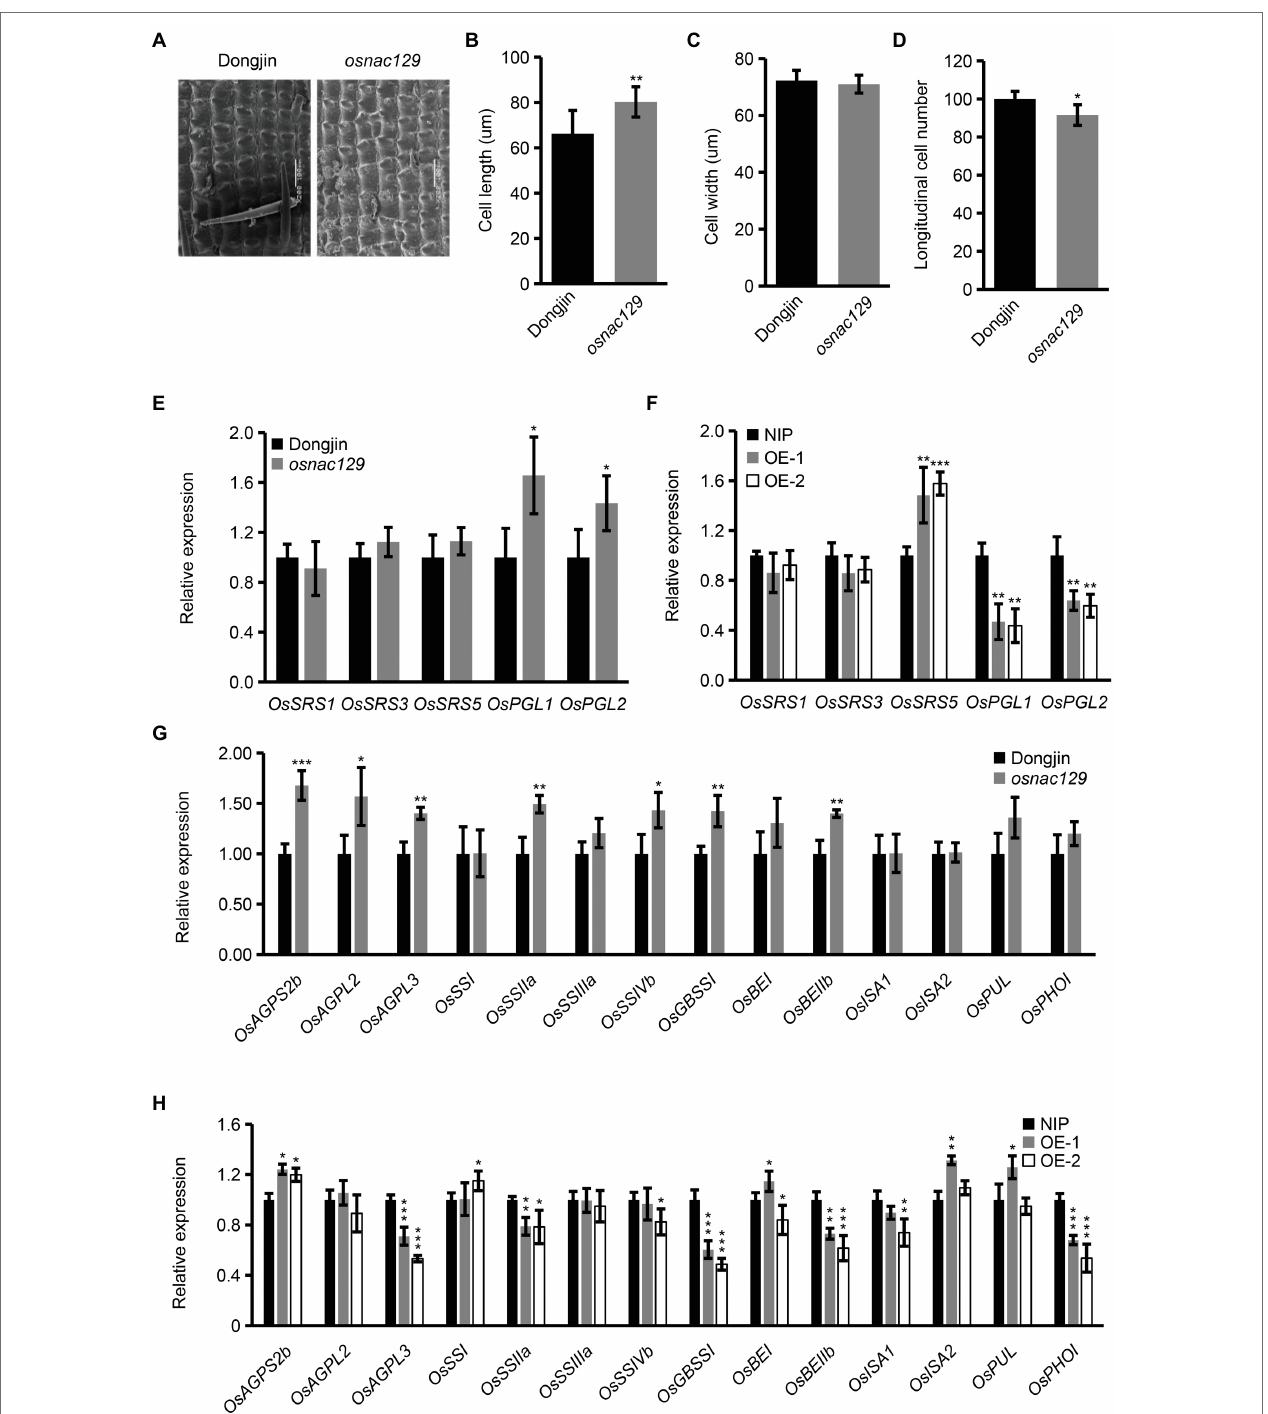
FIGURE 4 | OsNAC129 simultaneously regulates cell elongation and starch biosynthesis in rice seeds. (A) Observation of the outer epidermal cells of WT and osnac129 mutant lemmas by SEM. Scale bars = 100 μ m. (B–D) Show the cell length, cell width, and cell number measurement of the outer epidermal cells of the lemma. Data are means ± SD of three replicates (each replicate consisted of at least 30 cells) in (B,C) , and four replicates in (D) ; ** p < 0.01, *** p < 0.001 as determined by Student’s t -test. (E,F) Show the relative expression determined by qRT-PCR of genes reported to be related to grain size by controlling cell elongation in seeds from the WT, osnac129 mutant, and OE plants at 7 DAF. UBQ10 was used as the internal control for normalization of gene expression. Data are means ± SD of four replicates. (G,H) Show qRT-PCR determination of expression of starch synthase-encoding genes in seeds of the WT, osnac129 , and OE plants at 7 DAF. UBQ10 was used as the internal control. Data are means ± SD of four replicates; * p < 0.05, ** p < 0.01, and *** p < 0.001 as determined by Student’s t